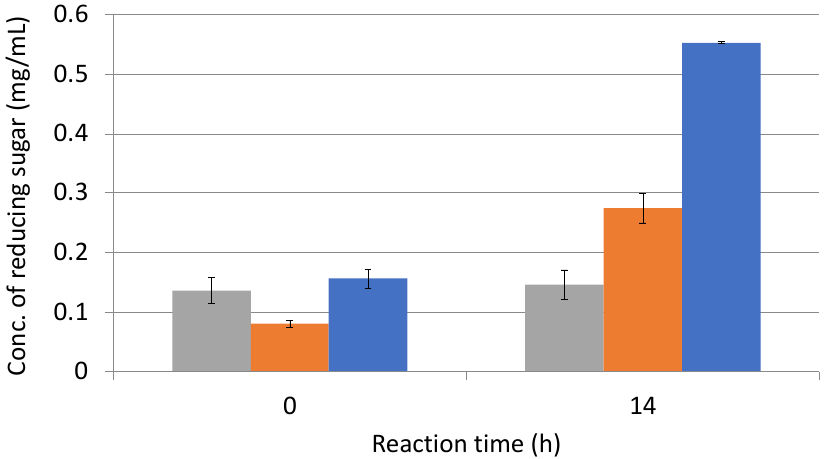
Figure 8. Enzymatic activities of 30-pass-treated sugarcane bagasse with L-cysteine. Grey bar, negative control with only phosphate buffer; orange bar, without L-cysteine; and blue bar, with 10 mM L-cysteine. A negative control was used with distilled water instead of enzyme solution.